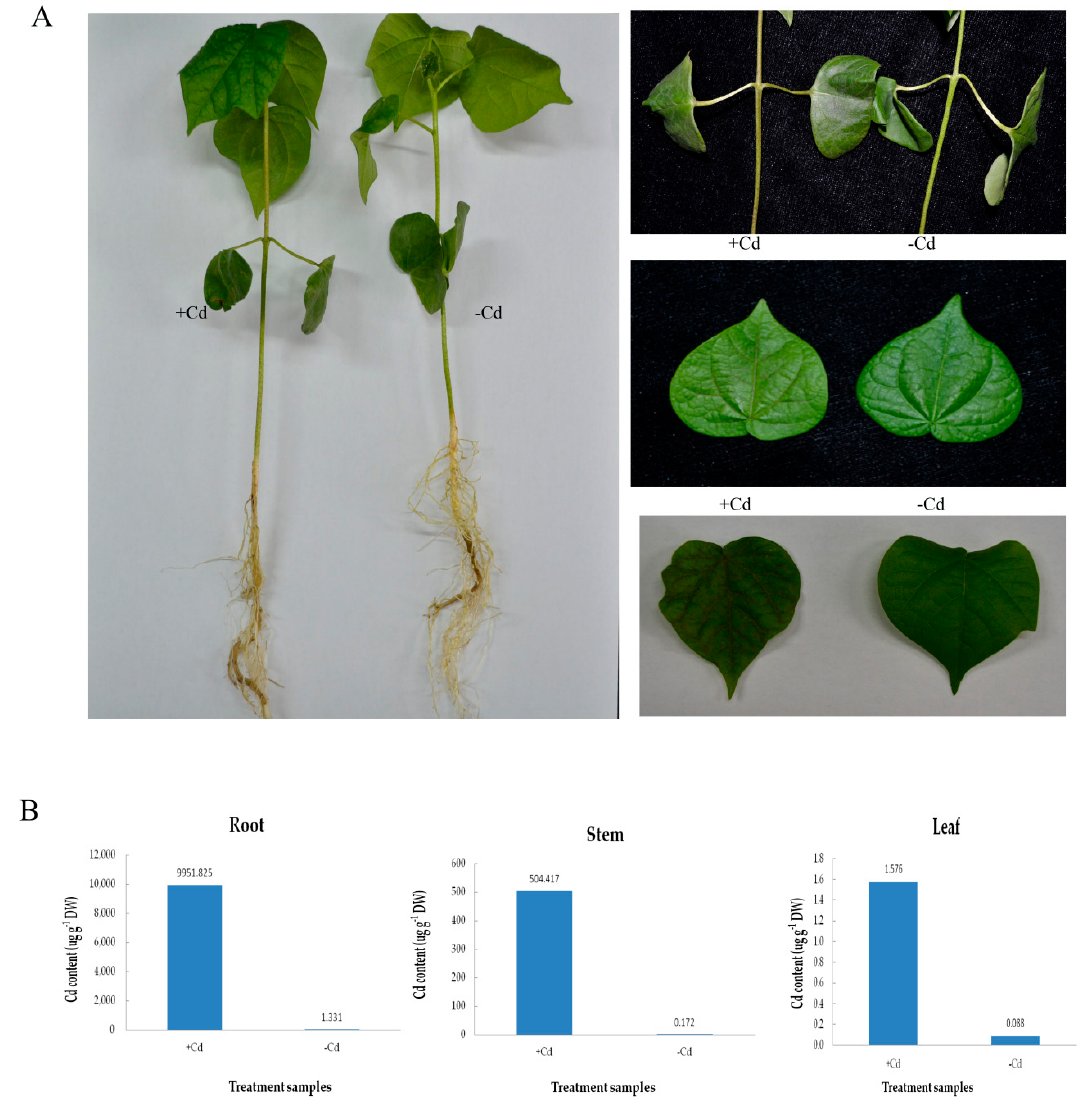
Figure 1. Phenotypic symptoms ( A ) and Cd content ( B ) in roots, stems and leaves of Han242 cotton seedlings with or without 4 mM Cd stress for 9 h.